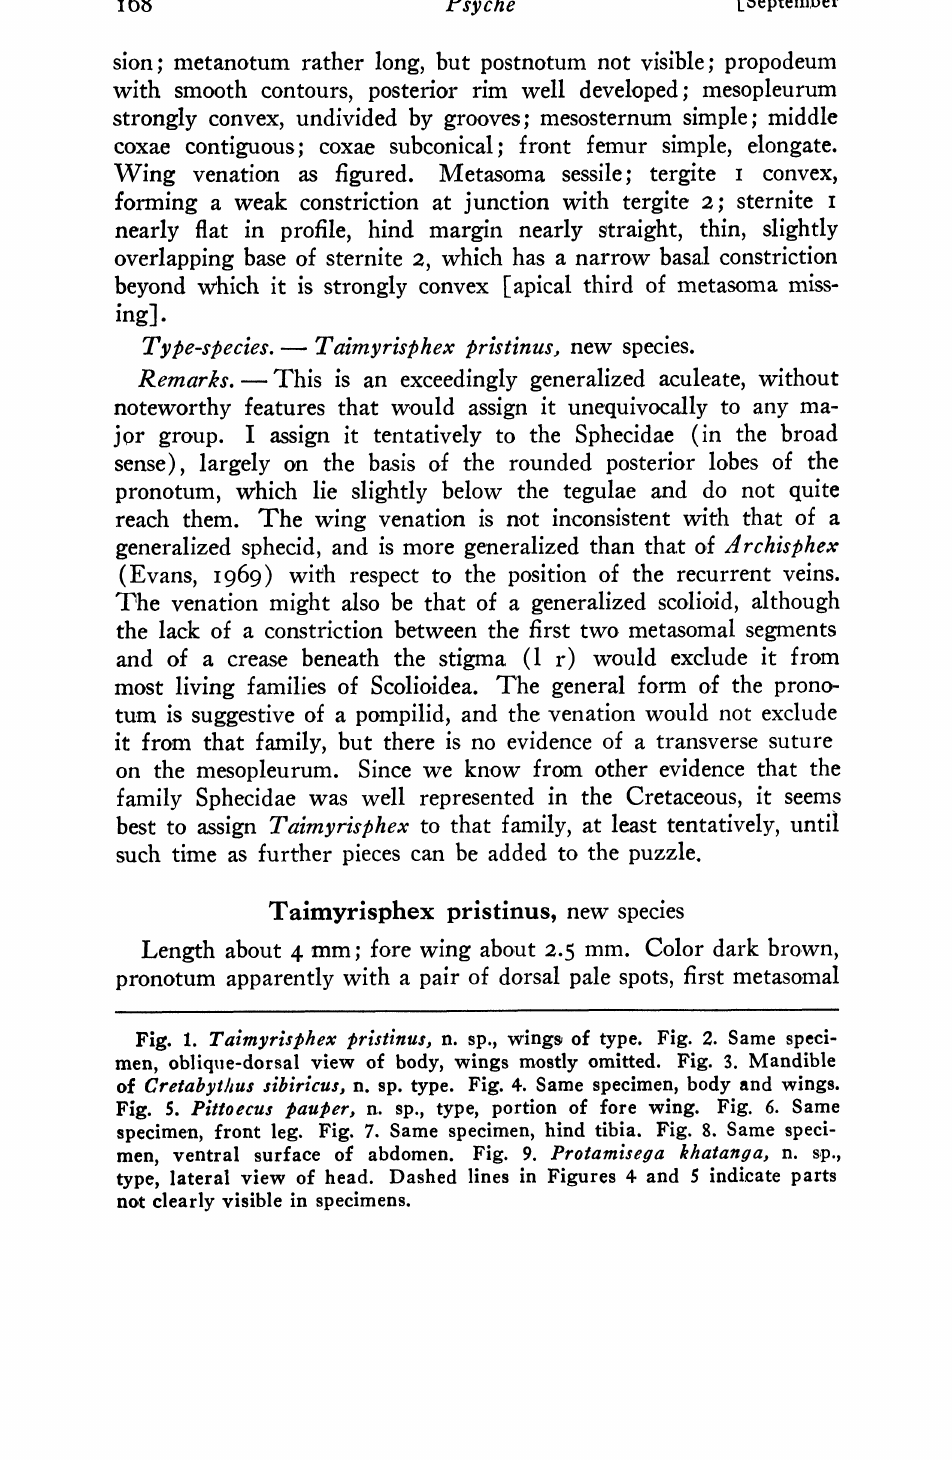
Fig. 1. Taimyris#hex lristinus, n. sp., wings of type. Fig. 2. Same speci- men, oblique-dorsal view of body, wings mostly omitted. Fig. 3. Mandible of Cretabythus sibirlcus, n. sp. type. Fig. 4. Same specimen, body and wings. Fig. 5. Pittoecus lauler, n. sp., type, portion of fore wing. Fig. 6. Same specimen, front leg. Fig. 7. Same specimen, hind tibia. Fig. 8. Same speci- men, ventral surface of abdomen. Fig. 9. Protamisega khatanga, n. sp., type, lateral view of head. Dashed lines in Figures 4. and 5 indicate parts not clearly visible in